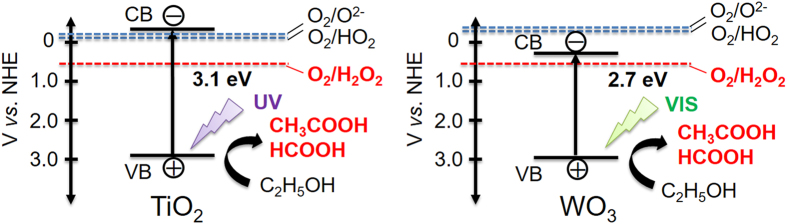
Relationship between the potential of oxygen reduction and the band structures of TiO2 and WO3.